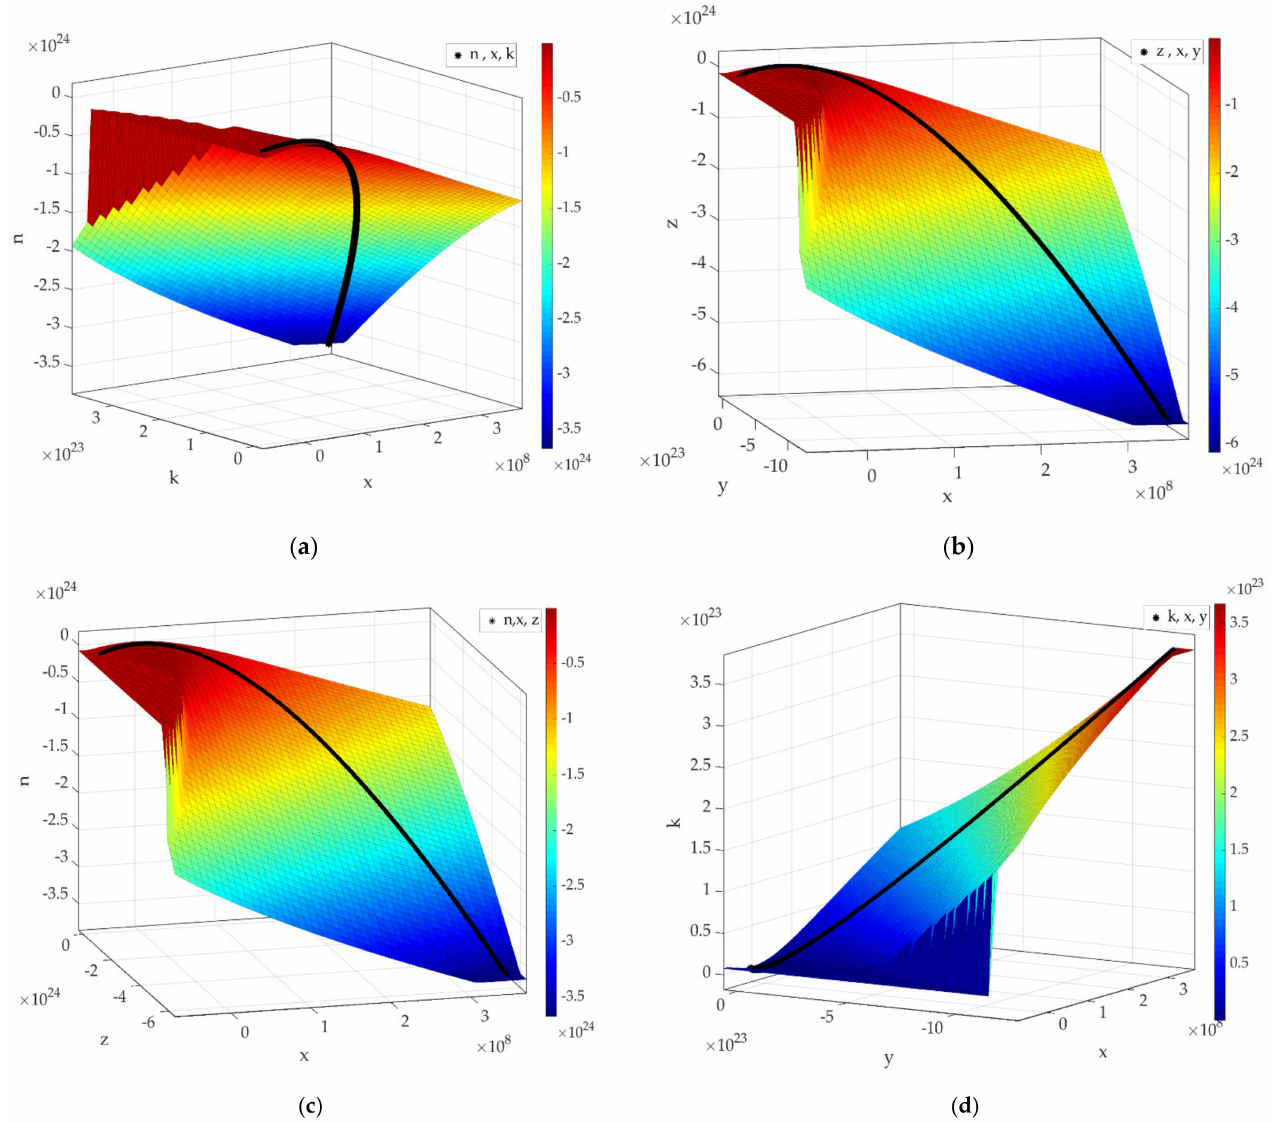
Figure 17. Nearest neighbor interpolant fitting with four modes: ( a ) f(x, k, n); ( b ) f(x, y, z); ( c ) f(x, z, n); ( d ) f(x, y,